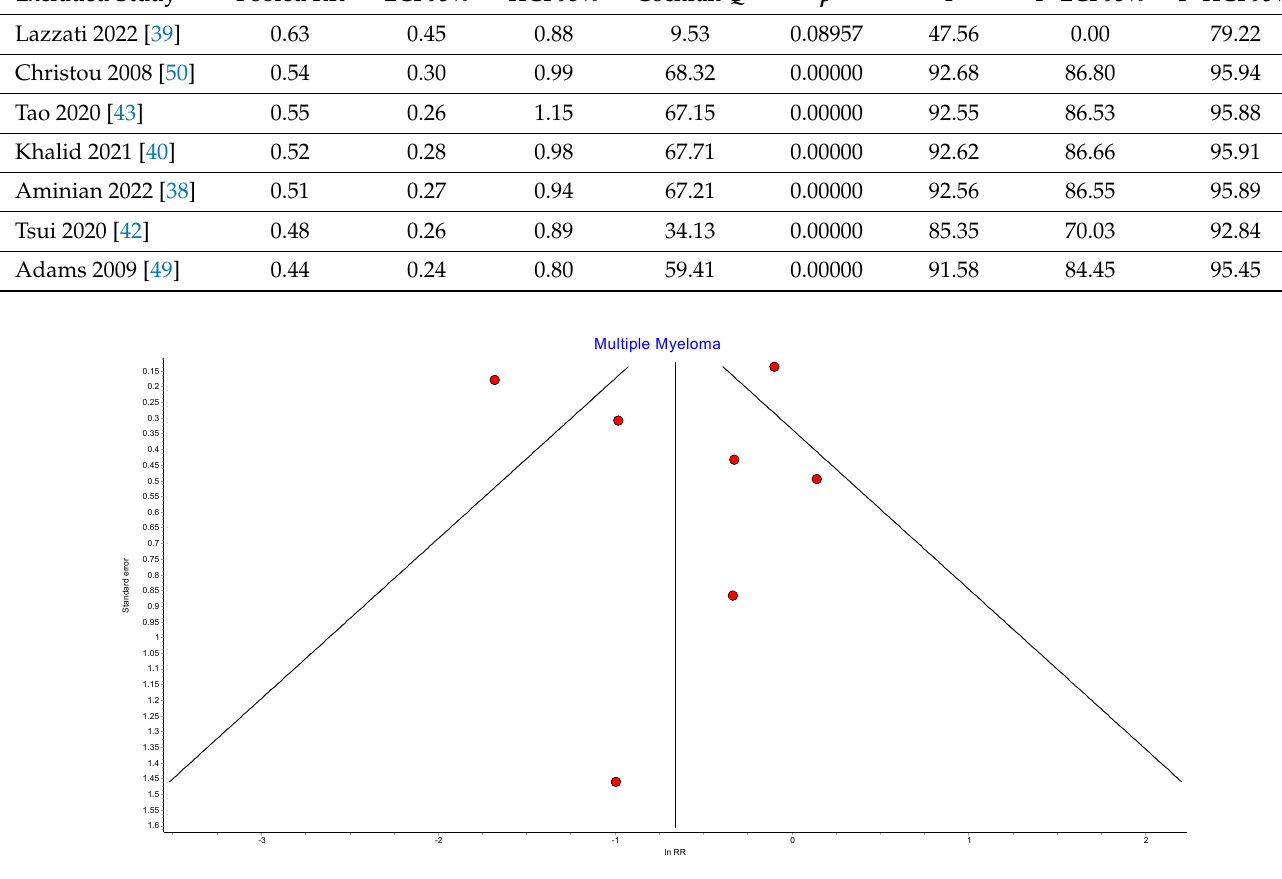
Figure A17. Multiple myeloma random effects model funnel plot. Table A17. Multiple myeloma random effects model sensitivity analysis.